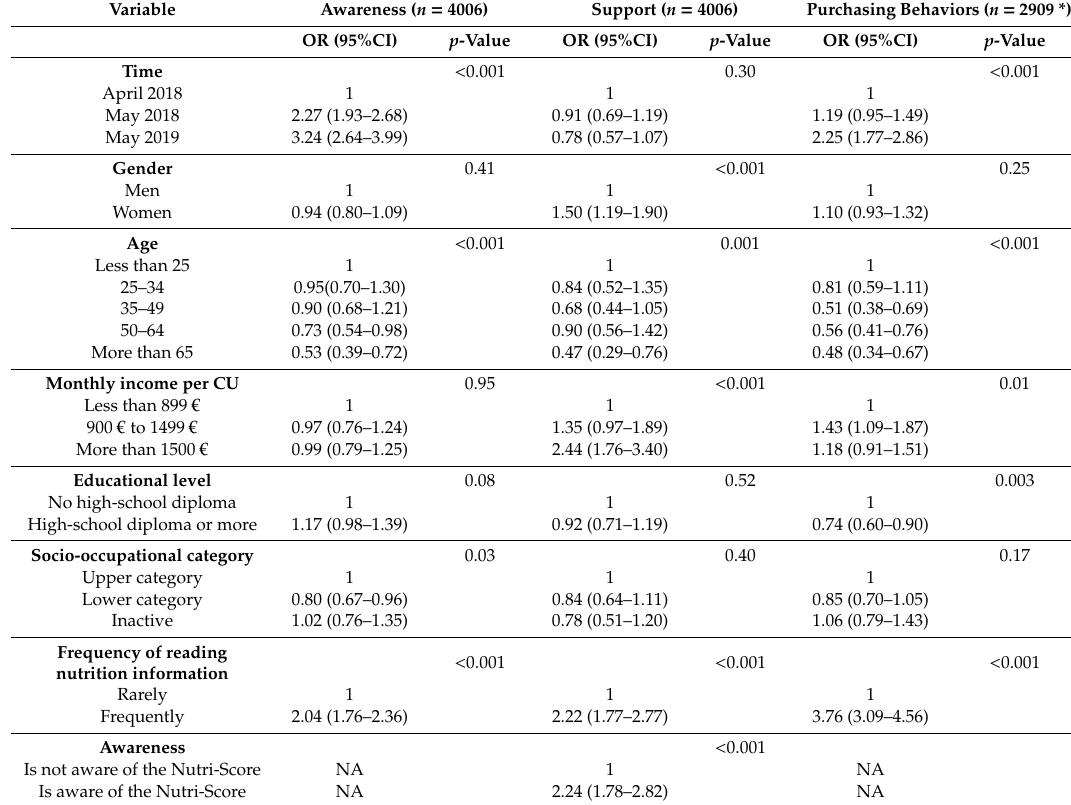
Table 4. Associations between awareness, support, or change in purchasing behaviors with individual characteristics and time using logistic regression